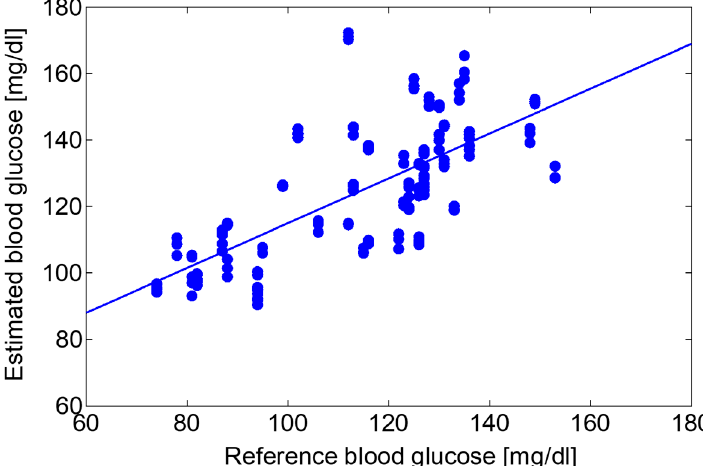
Figure 11. The correlation between the estimated values and the reference blood glucose levels measured by blood sampling.